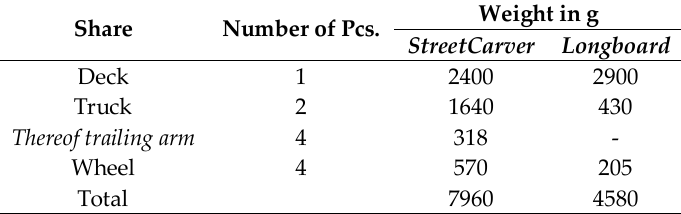
Table 1. Comparison of weight (measured): StreetCarver and conventional Longboard. Share Number of